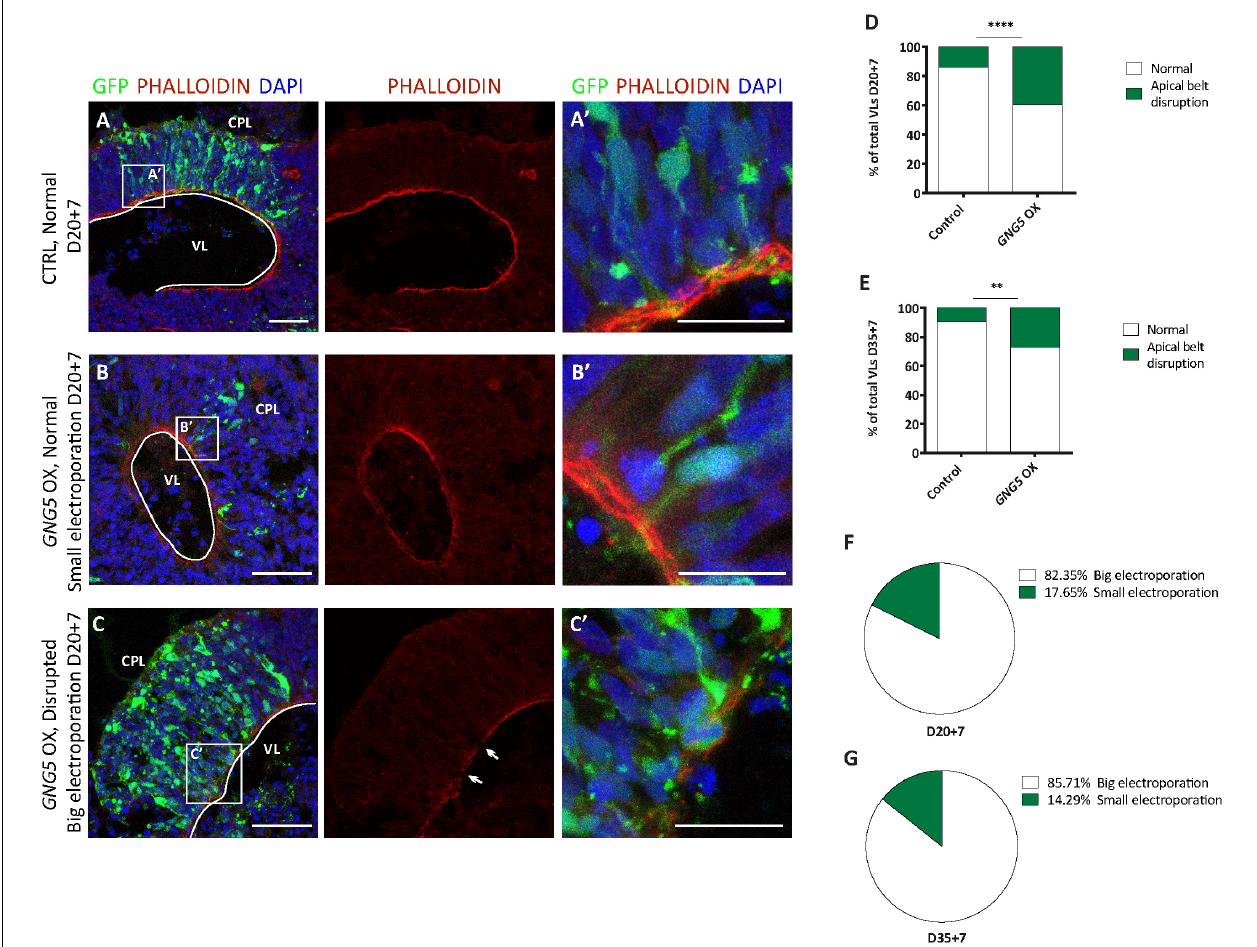
FIGURE 2 | Acute overexpression of GNG5 induces delamination problems in COs. (A,A (cid:48) ) Representative picture of an intact apical belt in control COs stained with the actin marker PHALLOIDIN, (B,B (cid:48) ) intact apical belt with small electroporation in GNG5 OX COs and ( C,C (cid:48) ) disrupted in GNG5 OX COs with big electroporation. Arrows indicate the location of the disrupted belt. (D) Percentage of VLs with an intact or disrupted apical belt at 20 + 7 days and (E) 35+7 days. ( F ) Percentage of VLs with a small or big electroporation and a disrupted apical belt after GNG5 OX at 20 + 7 days and ( G ) 35+7 days. PHALLOIDIN statistical analysis was based